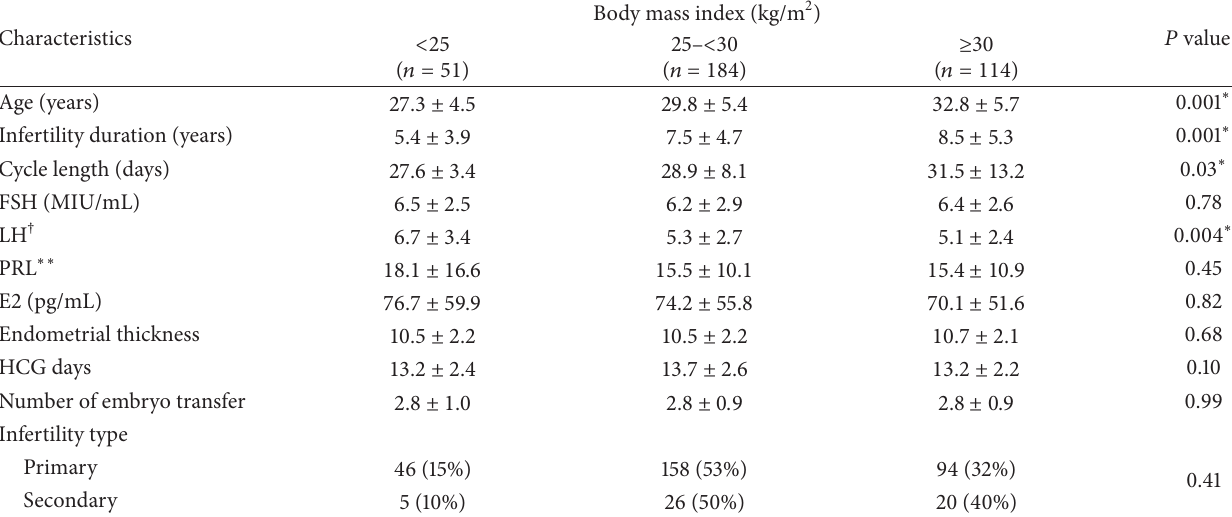
Table 1: Distribution of the studied women by body mass index in relation to their characteristics.